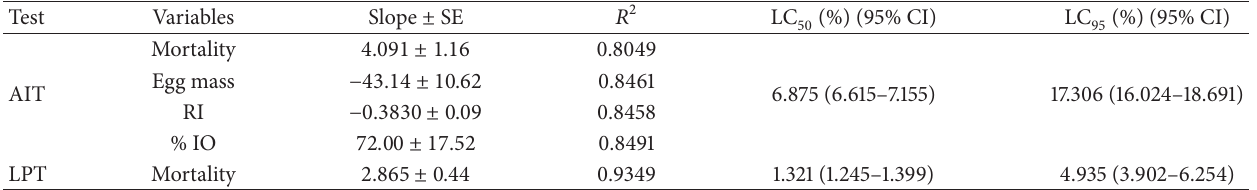
Table 2: Dose-response data of R . ( B .) microplus against methanolic extract of Atropa belladonna using adult immersion test (AIT) and larval packet test (LPT).